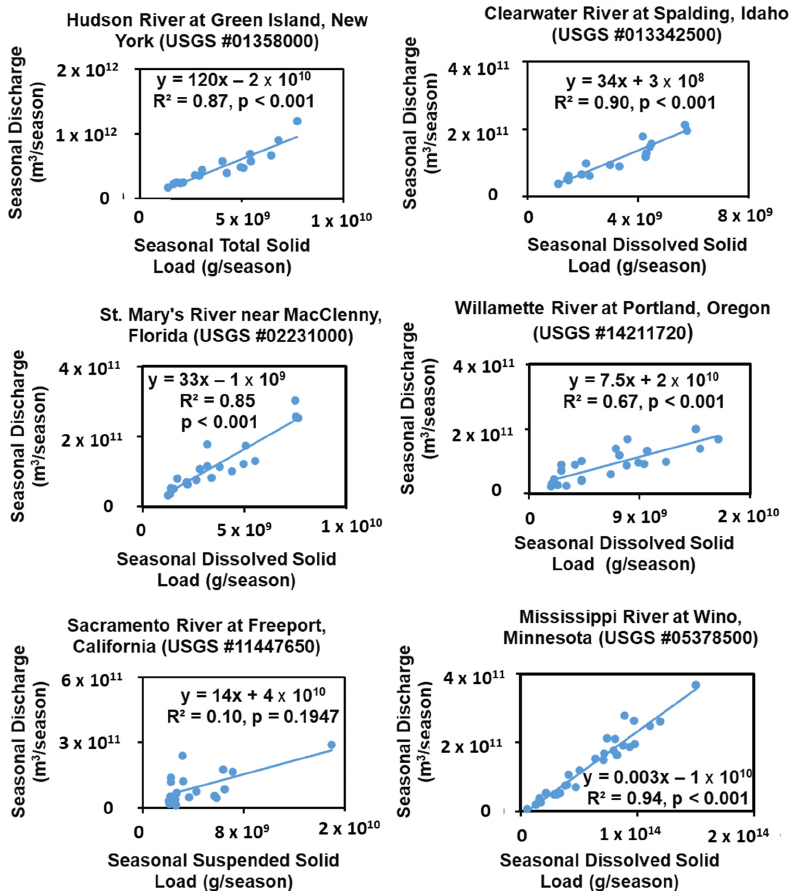
Figure 2. Correlations between the measured seasonal sediment loads and the measured seasonal discharges for the six USGS gage stations.